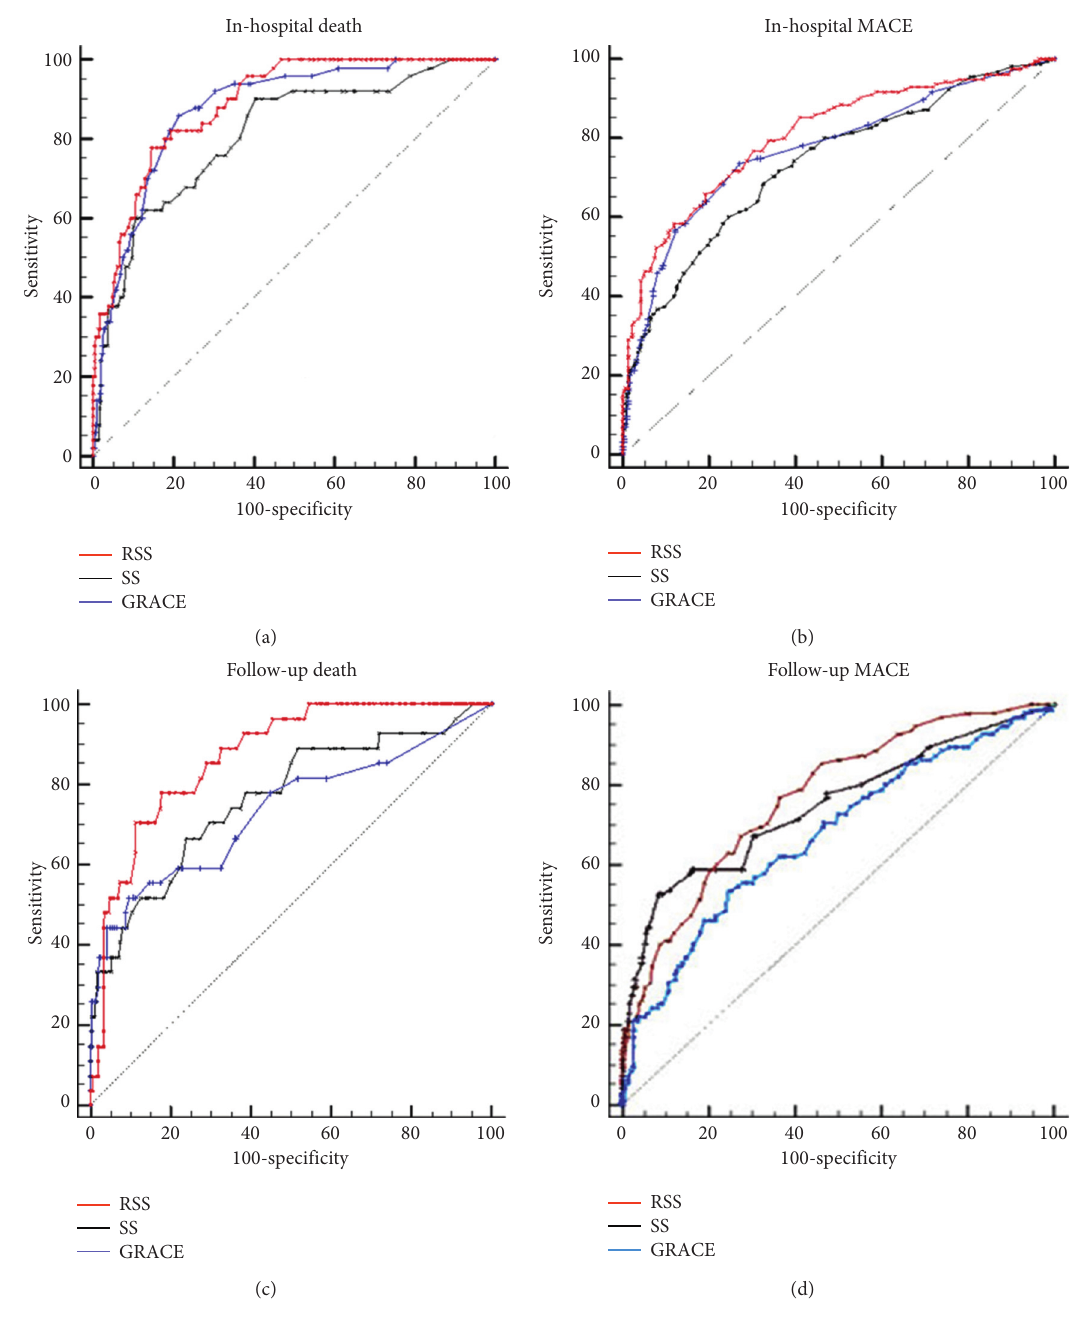
Figure 4: ROC curve analyses for